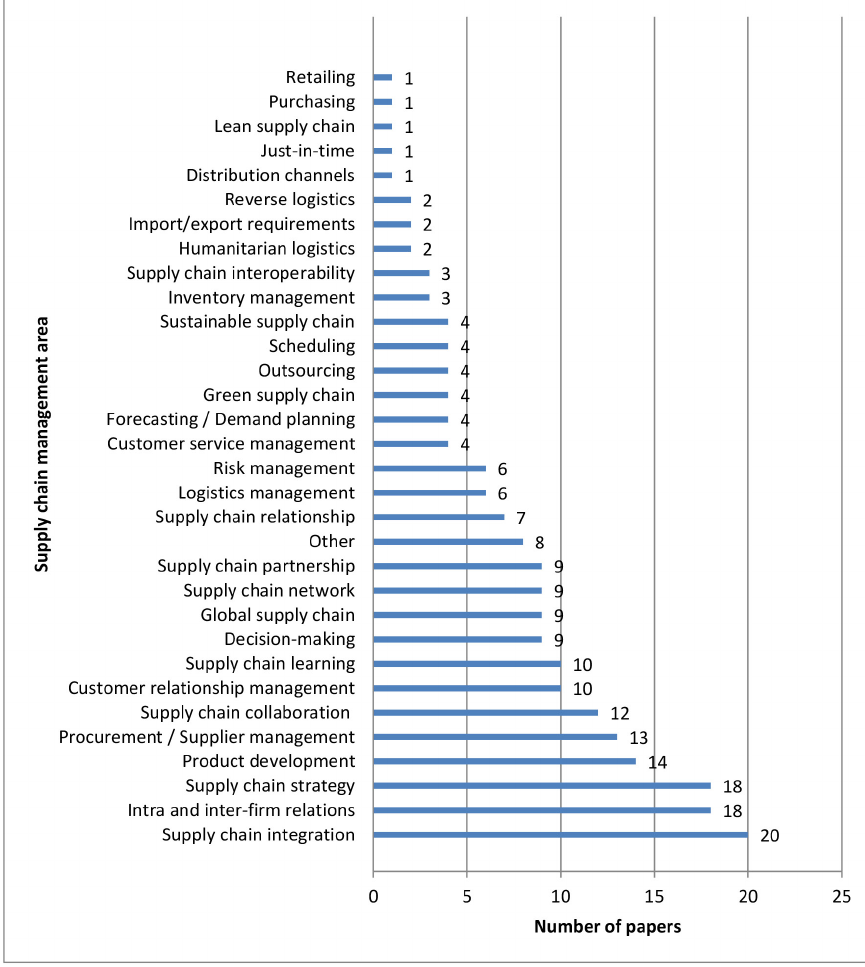
Figure 3. Distribution of the reviewed papers by supply chain management